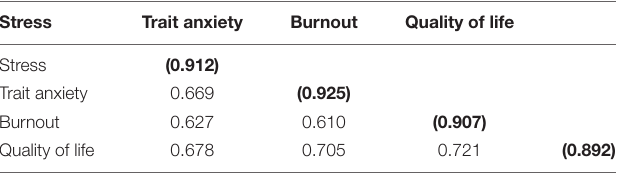
TABLE 1 | Divergence validity results (Fornell and larckell criterion).